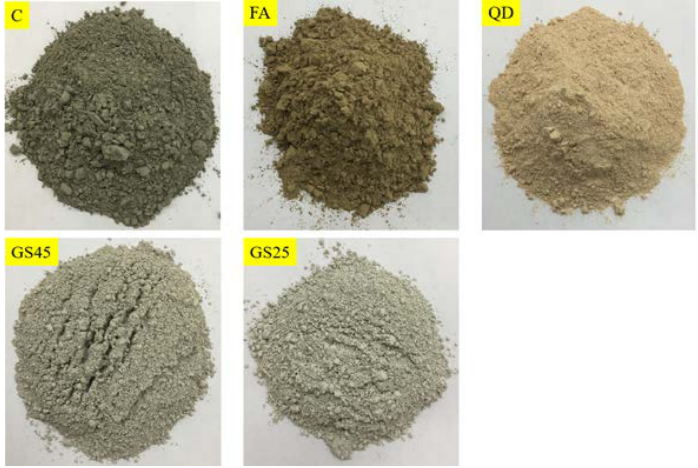
Figure 3. Materials in powder form as used in this study: cement (C); fly ash (FA); quarry dust (QD); granite sludge passing a 45-micron sieve (GS45) and a 25-micron sieve (GS25).